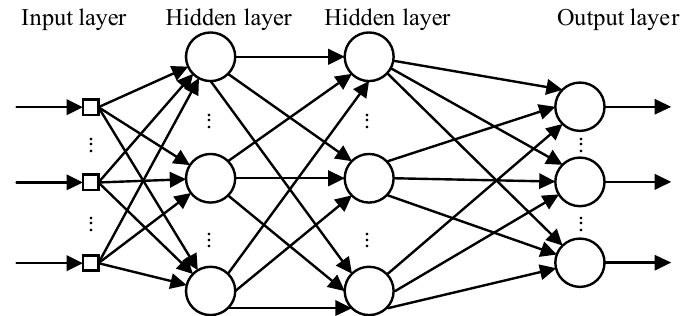
Figure 11. Neural network model.